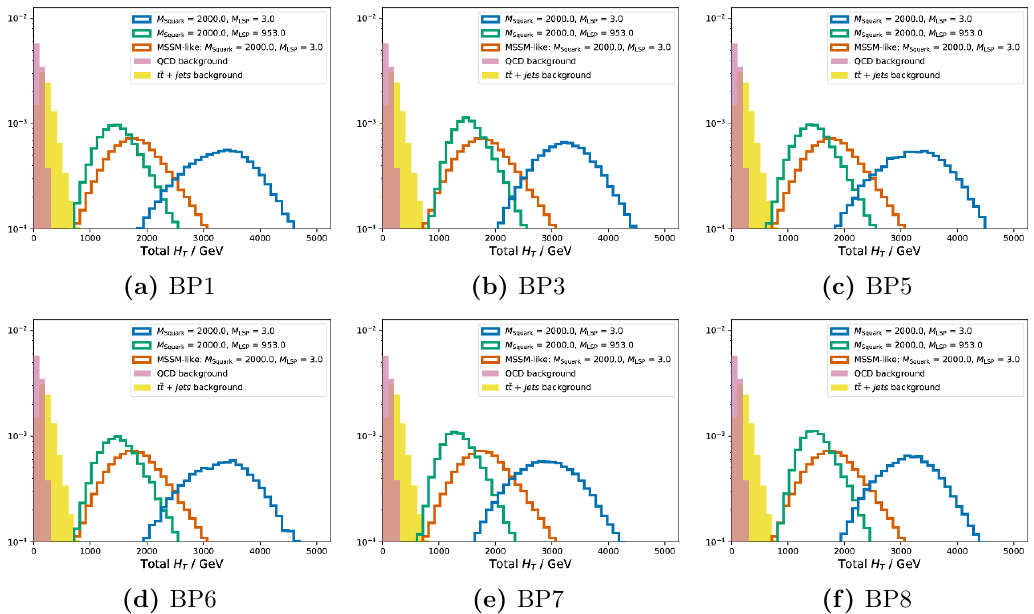
Figure 5. H T distributions for low and mid-range M LSP near the observed limit in the BP1- type scan, compared with QCD and t (cid:22) t background processes and an MSSM-like scenario with a light